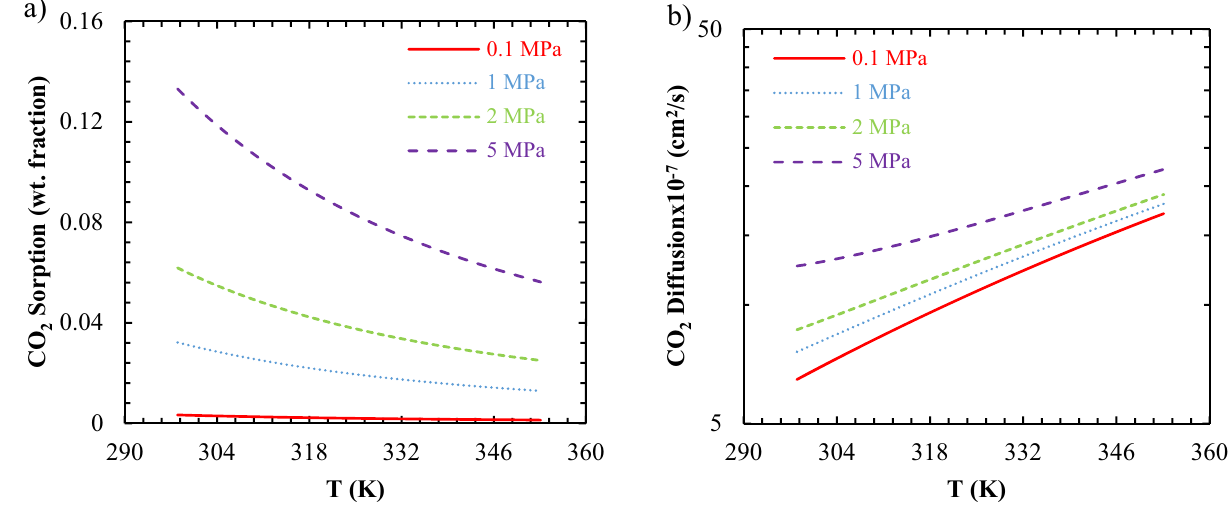
Figure 9. The prediction of the pressure-induced (0.1 to 5 MPa): ( a ) sorption and ( b ) diffusion as a function of temperature (25–80 °C) for the CO 2 /TPU-1